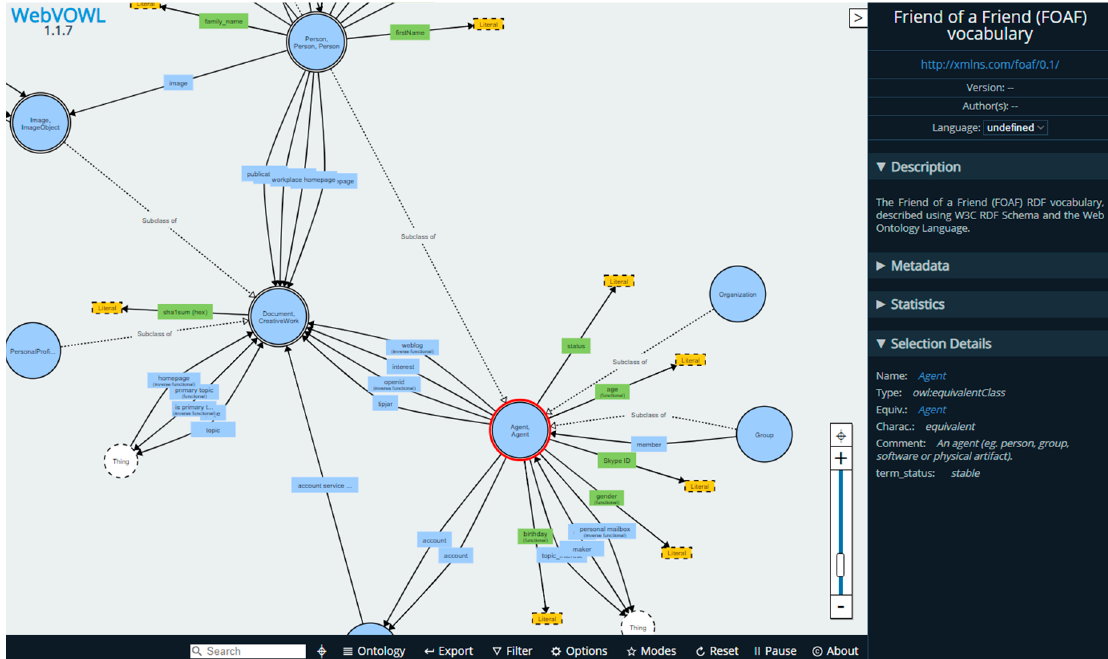
Figure 3. WebVOWL: Context and details subviews loaded with supplied Friend of a Friend Ontology. Source: Image generated from WebVOWL: Web-based Visualization of Ontologies resource http://vowl.visualdataweb.org/web- vowl.html.